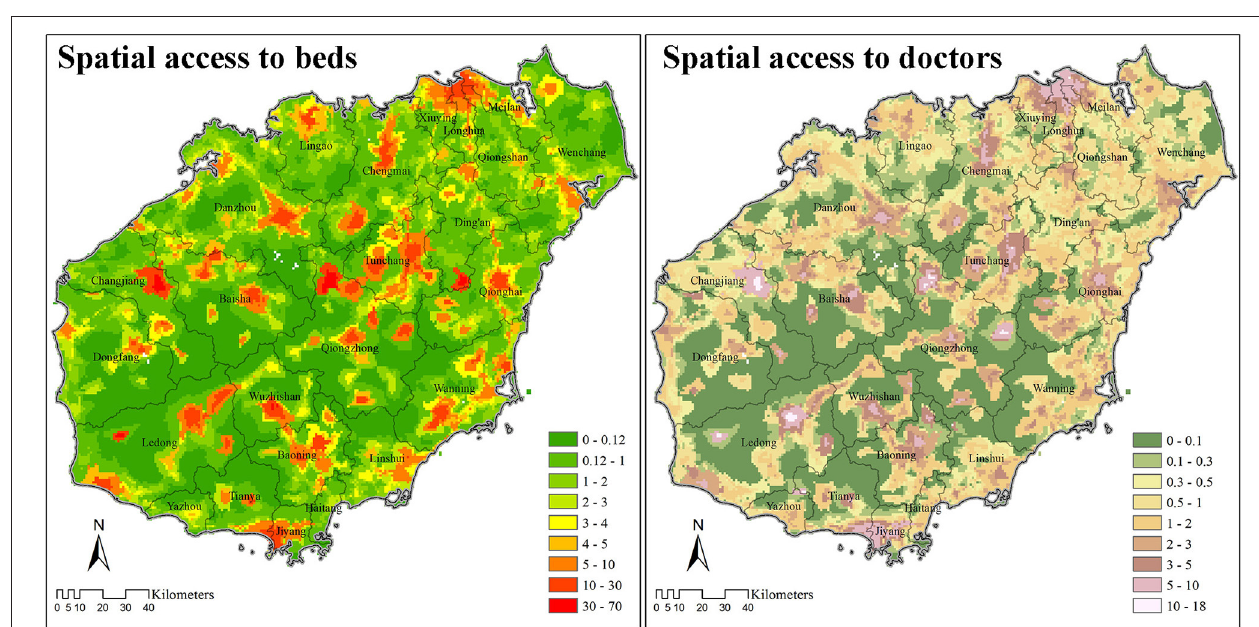
FIGURE 4 | Spatial access to beds and doctors (including registered and registered-assistant doctors) based on E2SFCA method on Hainan Island (2018).